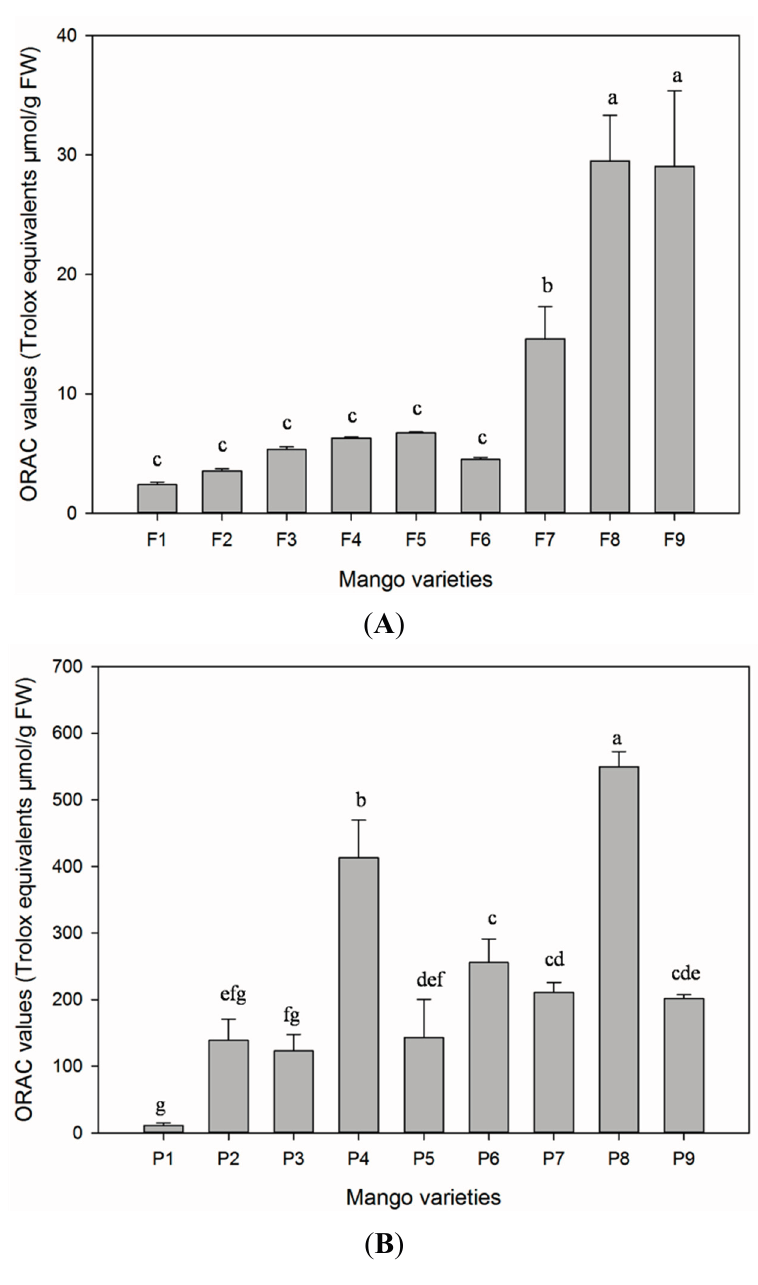
Figure 3. ( A ) ORAC value in pulp samples, the means of three replicates ± SD; different letters “a–c” indicate significant difference at p < 0.05; ( B ) ORAC value in peel samples; the means of three replicates ± SD; different letters “a–g” indicate significant difference at p <